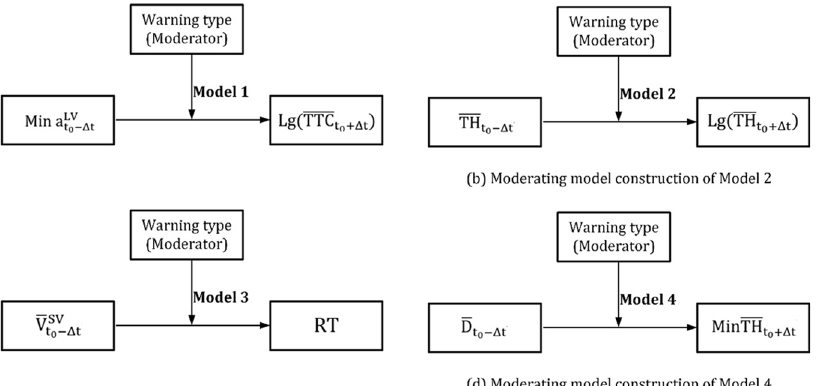
Figure 8 Three models with signi fi cant moderating effects of FCW